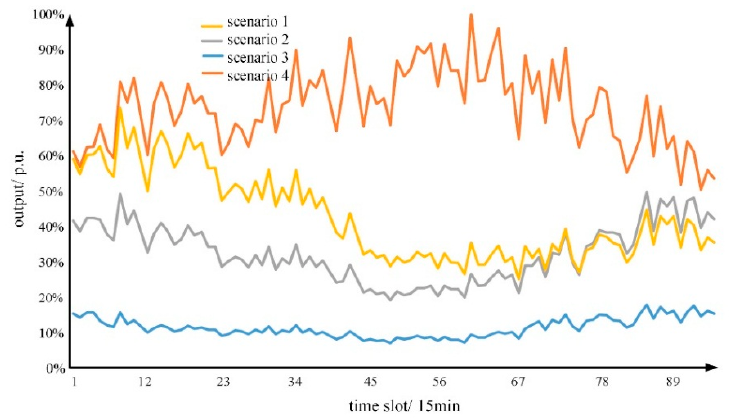
Figure 4. Garver-18 testing system.